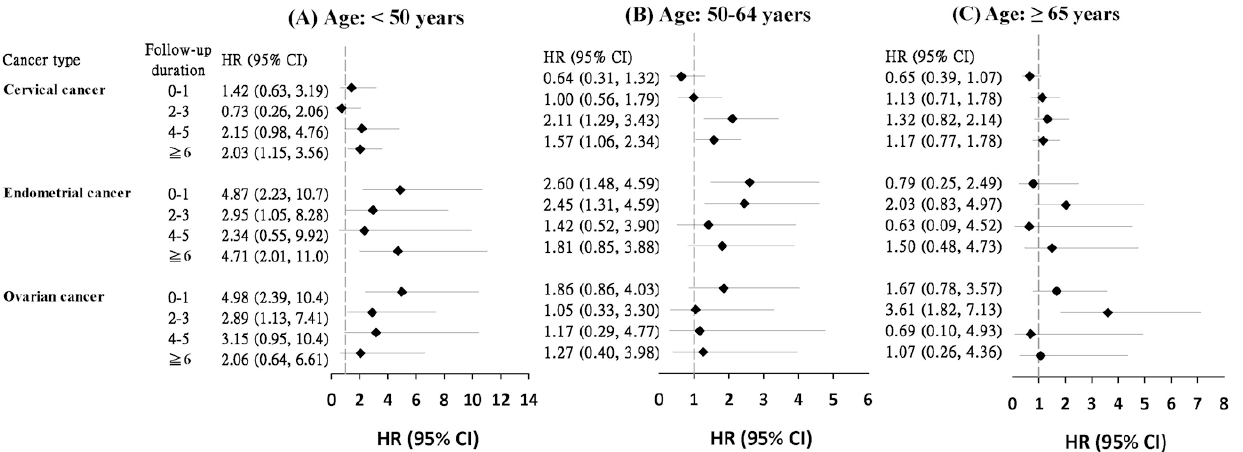
Figure 2. Cox proportional hazards regression analysis estimated adjusted hazard ratios of colorectal cancer for patients with gynecologic cancers relative to comparison cohort by follow-up year and age group. ( A ) Age: <50 years, ( B ) Age: 50–64 years, ( C ) Age: ≥ 65 years